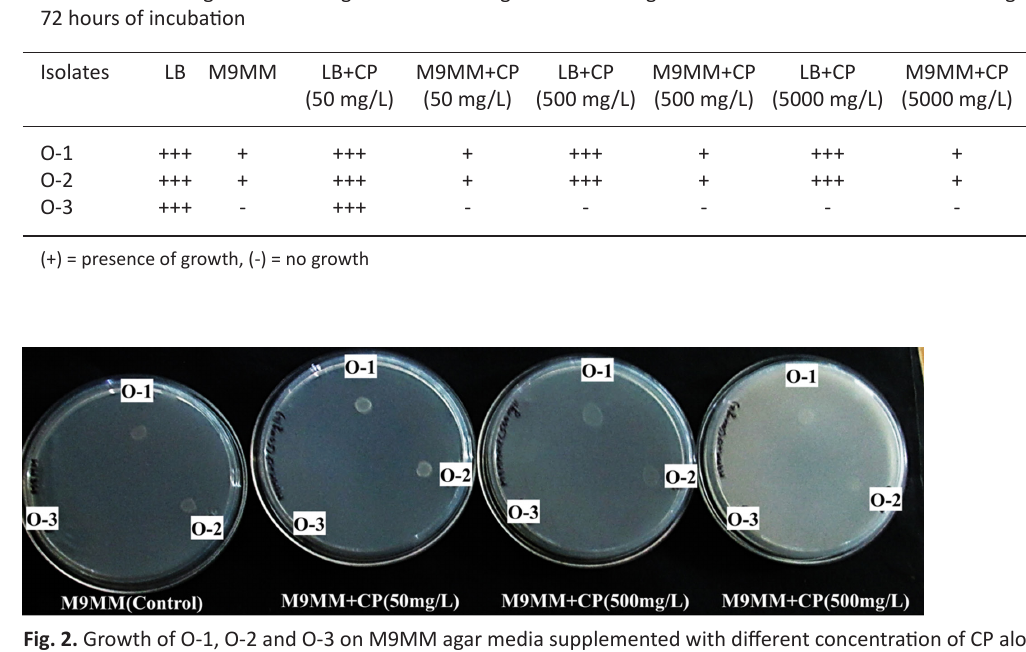
Fig. 2. Growth of O-1, O-2 and O-3 on M9MM agar media supplemented with different concentration of CP along with controll without CP